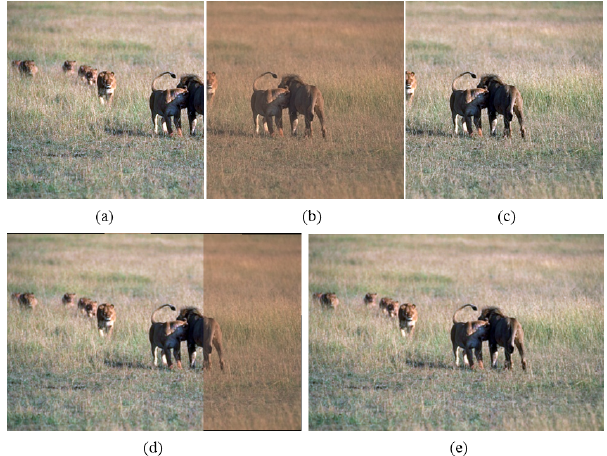
Figure 1. An example of color transfer in image stitching. ( a ) reference image; ( b ) test image; ( c ) color transfer for the test image using the reference color style; ( d ) stitching without color transfer; ( e ) stitching with color transfer. Image Source: courtesy of the authors and databases referred on